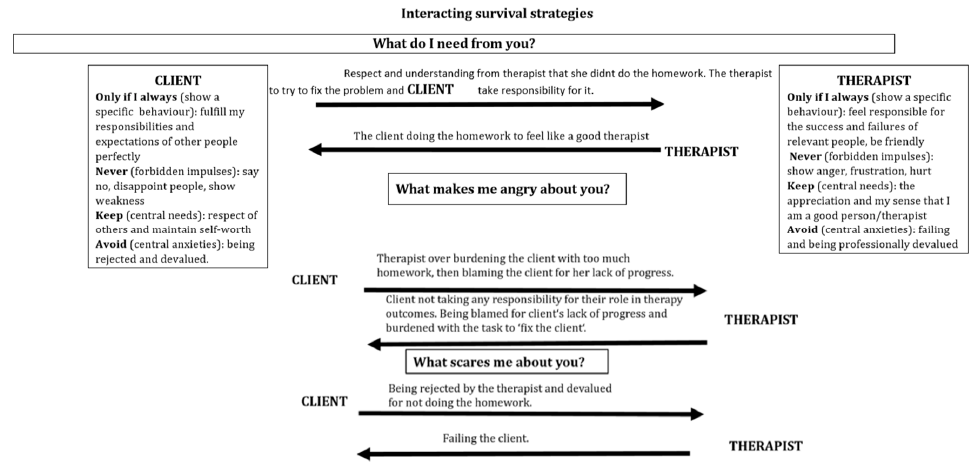
Figure 4. Hypothetical interacting survival strategies between a therapist and a client resulting in escalation.